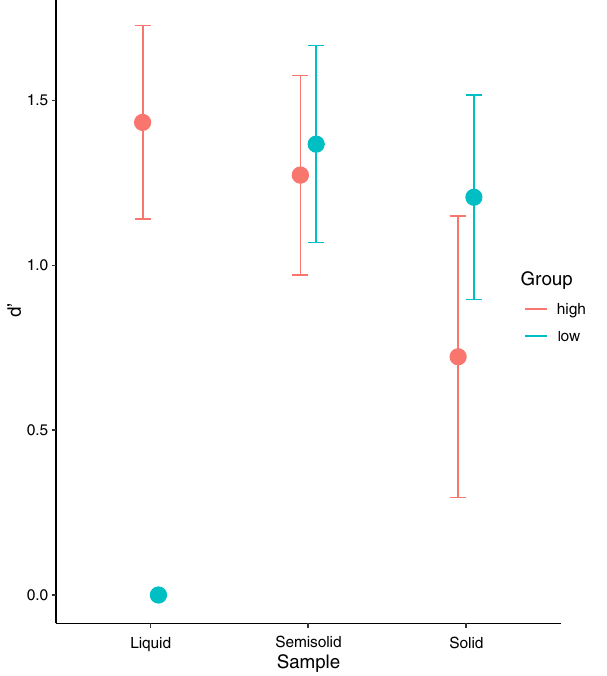
Figure 1. Discriminatory differences between touch sensitivity groups measured with d-prime (d ′ ).